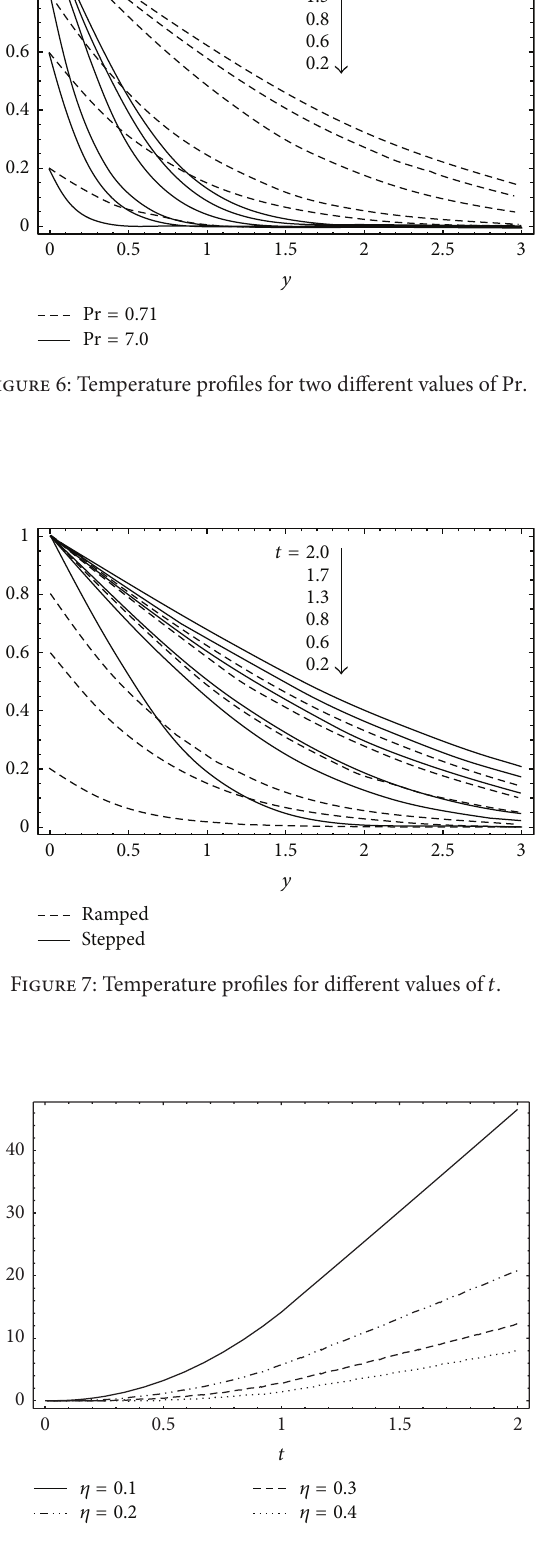
Figure 8: Variations of skin friction 𝜏 along 𝑡 for different values of 𝜂 corresponding to ramped temperature of the plate with Pr = 0.71